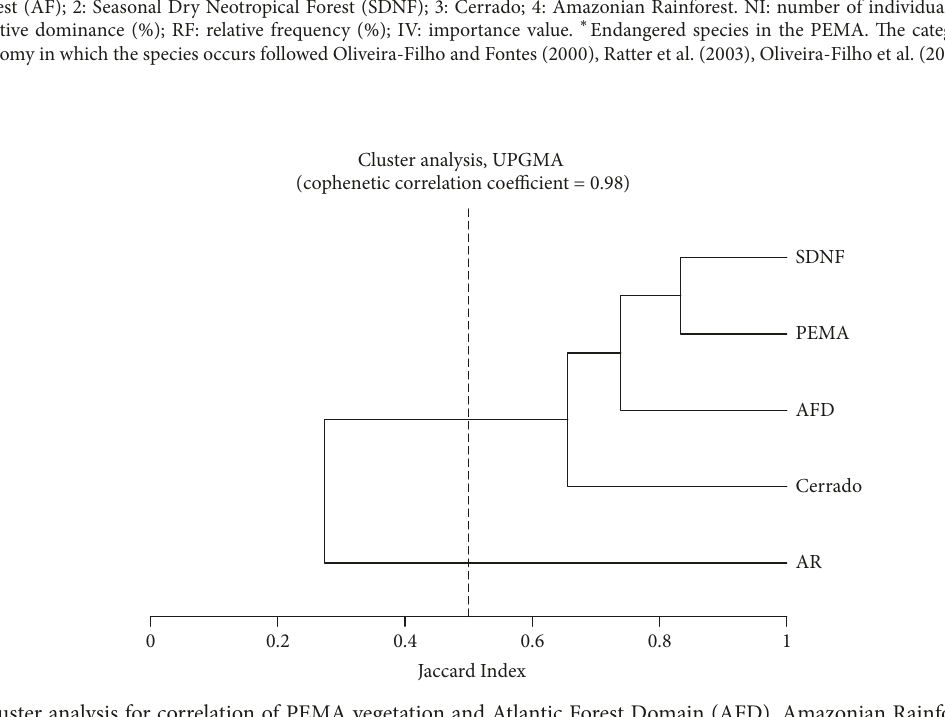
Figure 4: Cluster analysis for correlation of PEMA vegetation and Atlantic Forest Domain (AFD), Amazonian Rainforest (AR), Cerrado, and Seasonal Dry Neotropical Forest